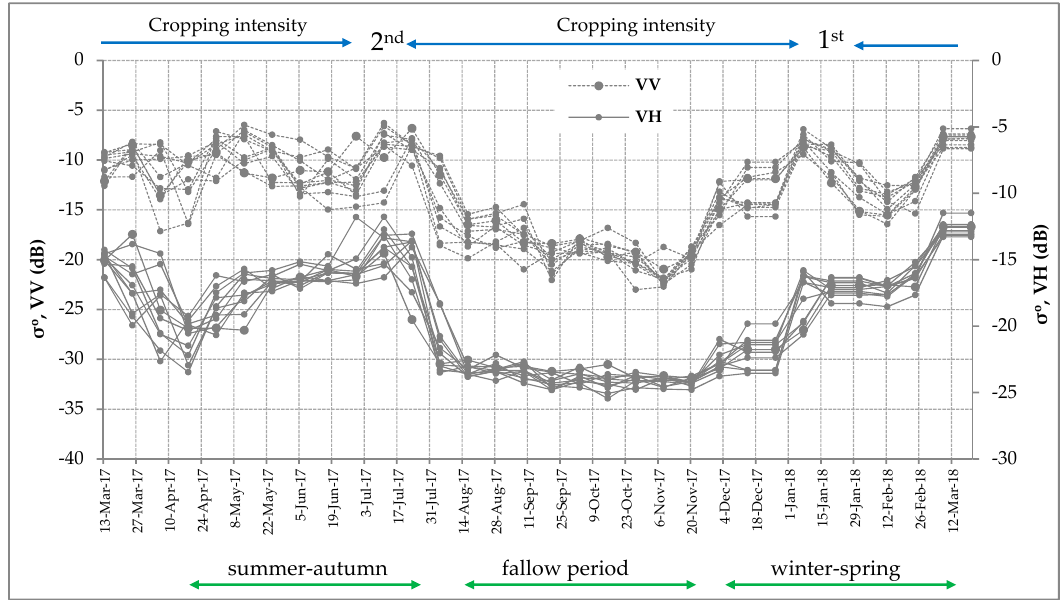
Figure 9. Graph representing the multitemporal Sentinel-1 A backscattering in the double-rice cropping area. The first vertical axis is σ o VV and the second vertical axis is σ o VH. The minimum and maximum values of VH backscatter for each rice crop were also identified.